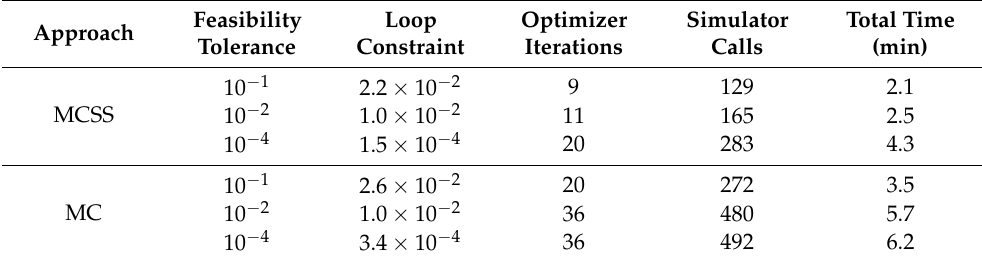
Table 8. Comparison between MCSS and MC: Optimization problem.